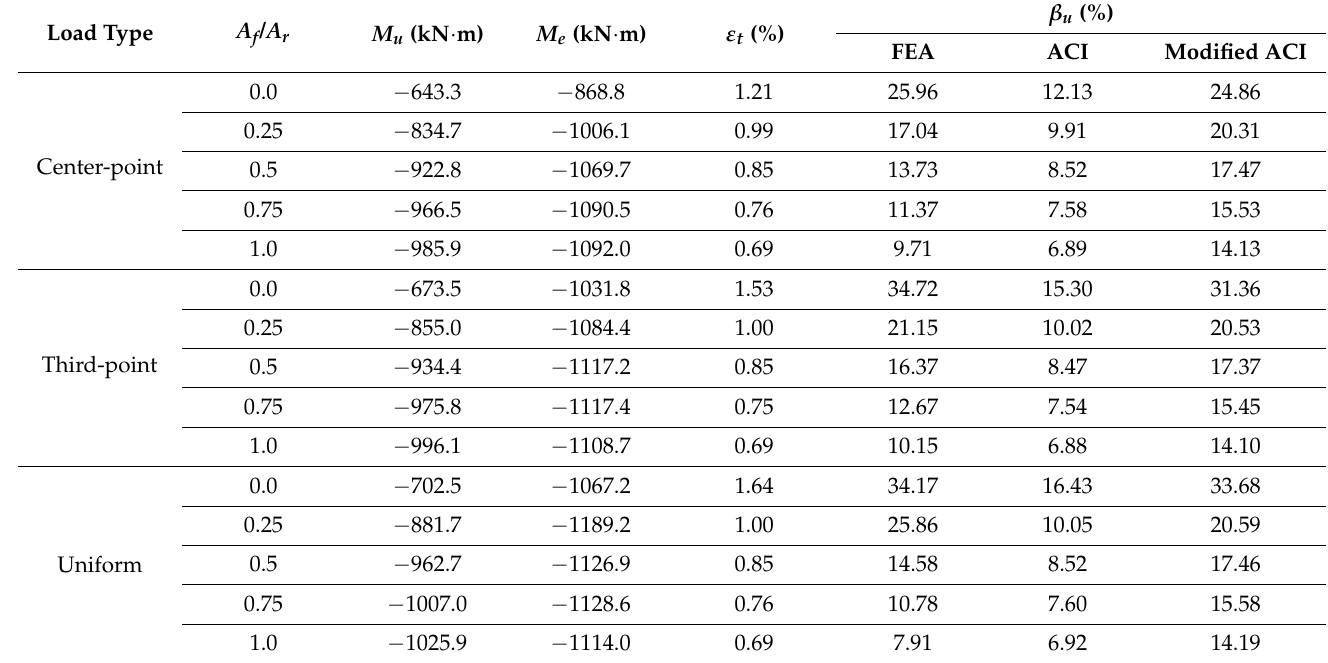
Table 2. Comparison of results in relation to moment redistribution in beams with different hybrid levels and load types.